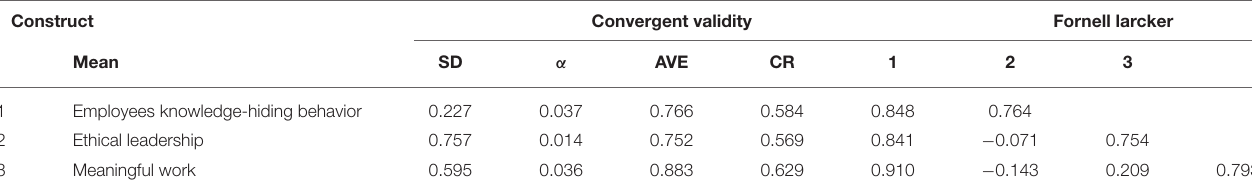
TABLE 3 | Convergent validity.